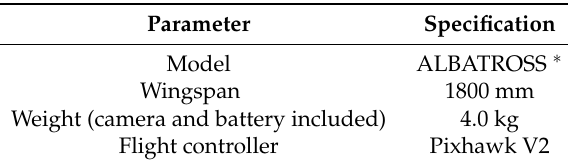
Table 2. Fixed wing unmanned aerial vehicles (UAV) used for navigation test.